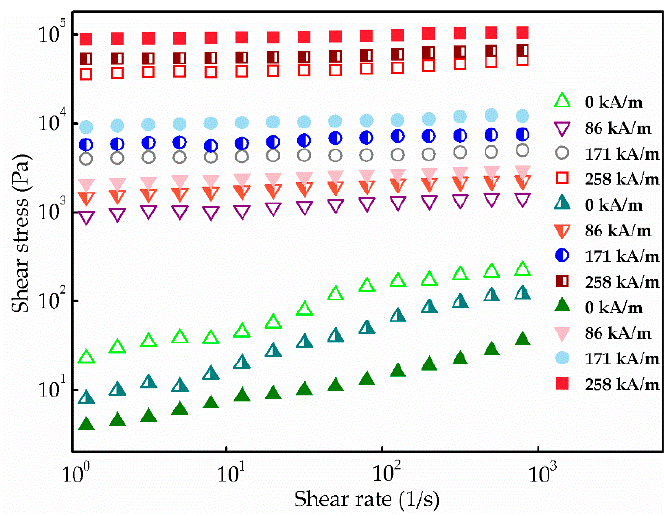
Figure 7. Shear stress curves for MR fluids based on CI@G (open symbol), CI@Fe 3 O 4 @G (semiclosed symbol), and CI@Fe 3 O 4 @G@GO particles (closed symbol) under various magnetic field strengths.